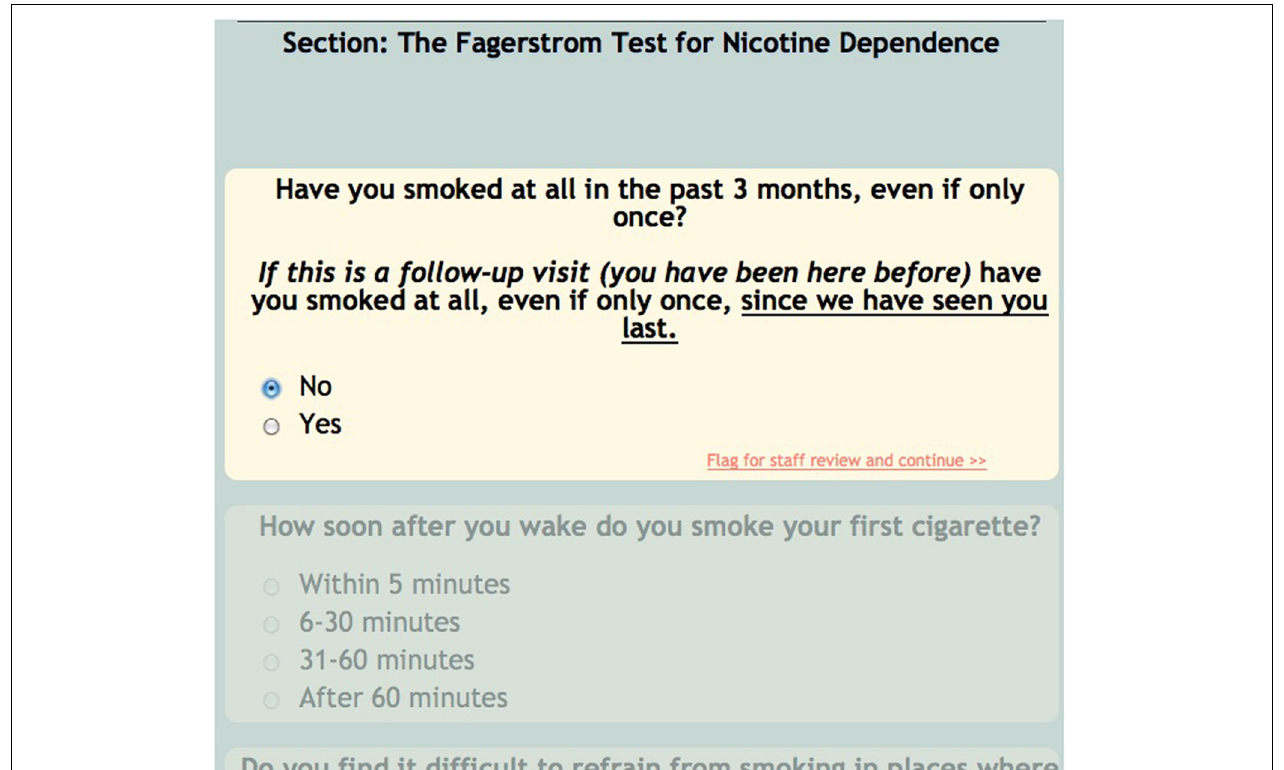
FIGURE 5 | Conditional skipping.